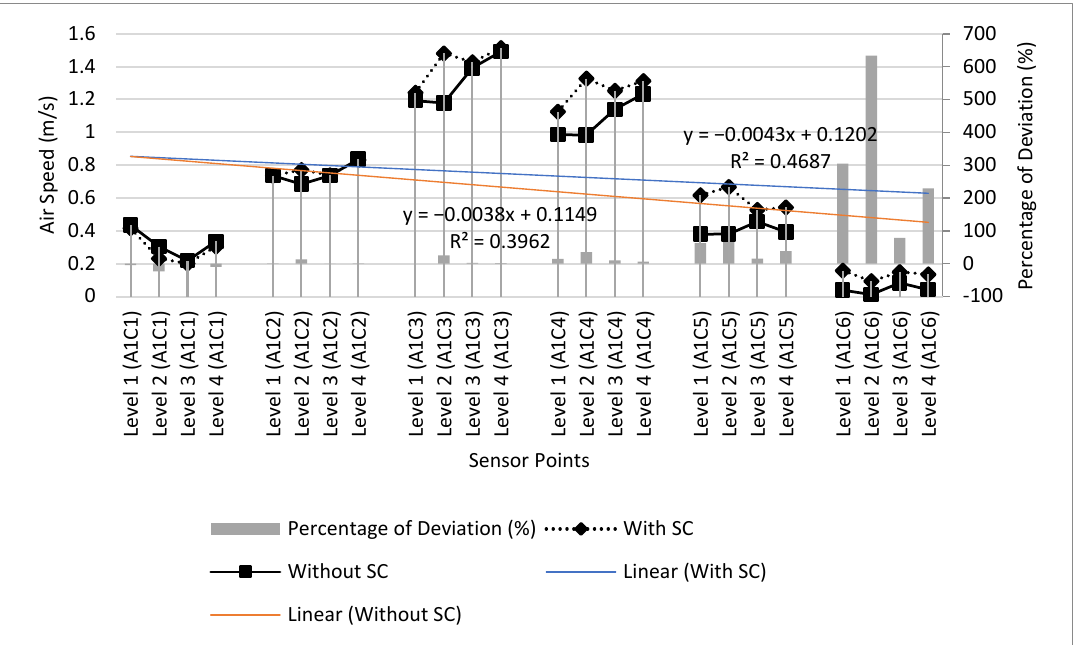
Figure 12. Comparison of indoor air speed between a room with an SC and a room without an SC, with the assistance of a ceiling fan.